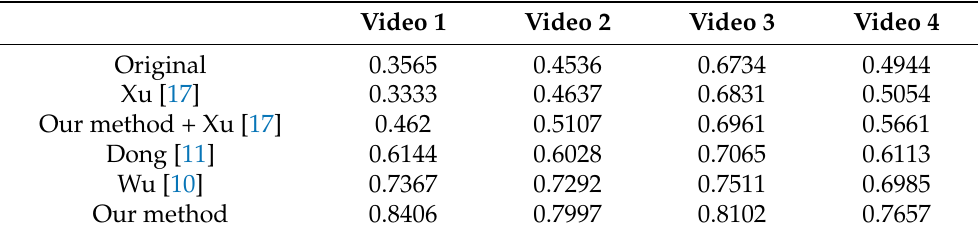
Figure 7. The tested image sequence: ( a ) shaky videos with single object, ( b ) only background shaking videos, ( c ) shaky videos with zooming, ( d ) shaky videos with crowds. Table 1. SSIM Comparison of different methods for shaky videos with single object.